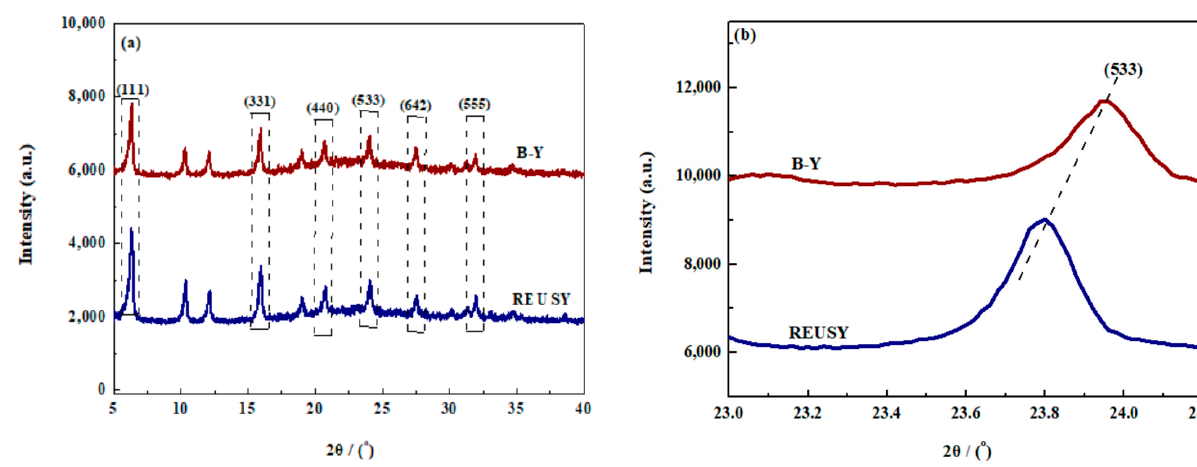
Figure 1. XRD patterns of REUSY zeolites ( a ) and (533) lattice planes ( b ).